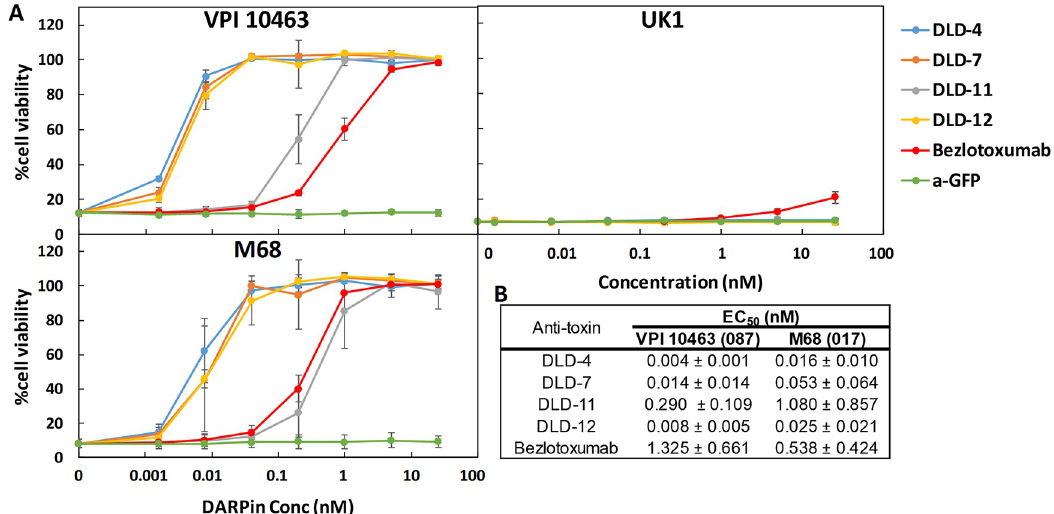
Fig 5. DARPin dimers offer superior protection to Vero cells against the toxicity of TcdB from C . difficile strains VPI 10463 (ribotype 087) and M68 (ribotype 017). (A) IMAC-purified DARPins were added to Vero cells (1.5 × 10 3 cells/well) together with TcdB toxin (2.5 pg/mL). Cell viability was quantified 72 hours later by the CellTiterGlo assay and normalized to na ï ve Vero cells. Error bars represent the standard deviation of at least 2 independent experiments done in duplicate. Bezlotoxumab is the FDA- approved monoclonal antibody for treating recurrent CDI [7]. a-GFP is a GFP-binding DARPin [15] and was used here as a negative control. (B) DARPin dimer TcdB-neutralization potency. Data are the averages of at least 2 independent experiments. CDI, Clostridium difficile infection; Conc, concentration; DARPin, designed ankyrin repeat protein; EC 50 , half maximal effective concentration; FDA, Food and Drug Administration; IMAC, Immobilized metal affinity chromatography; TcdB, C . difficile toxin B.